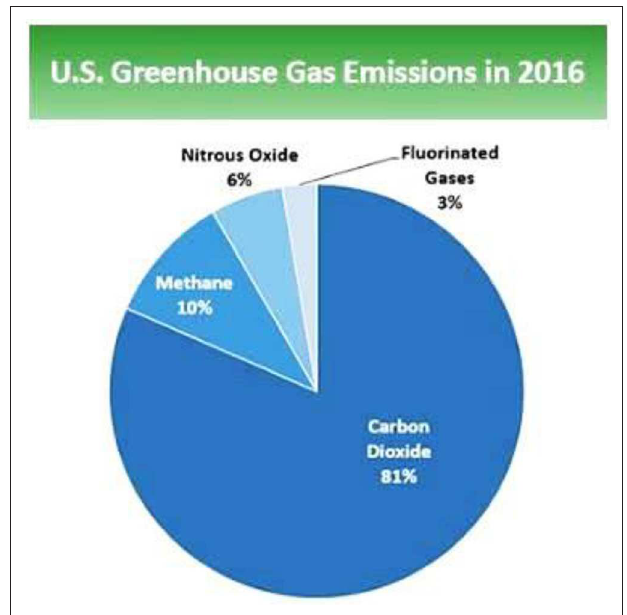
FIGURE 1 | Total greenhouse gas emission in 2016 (6,511 million metric tons) of CO 2 equivalent (US Energy Information Administration,